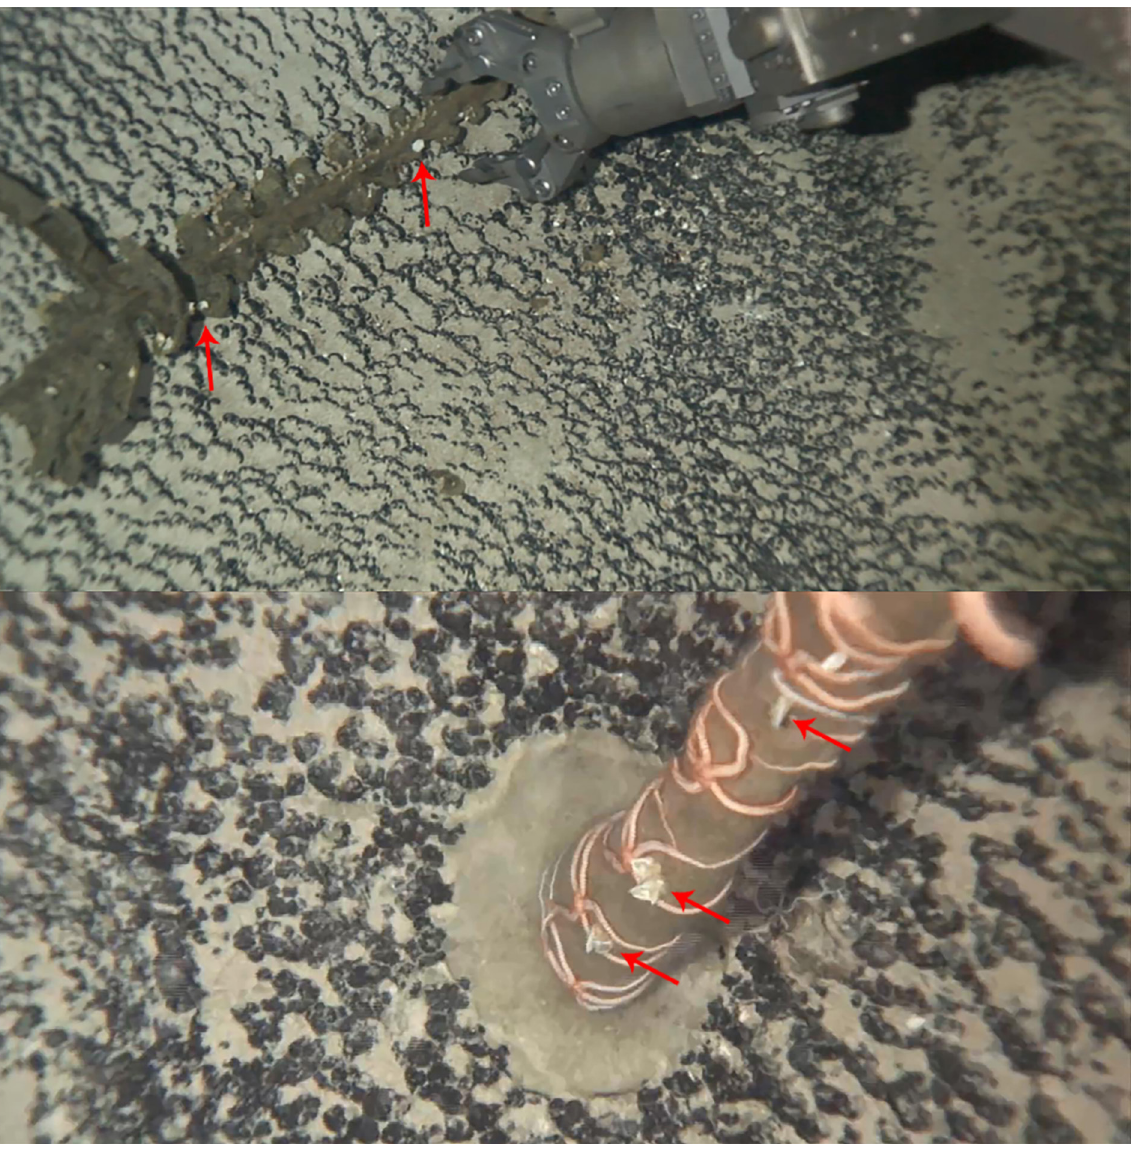
Fig. 4. In situ figures of Gibbosaverruca weijiai sp. nov. (red